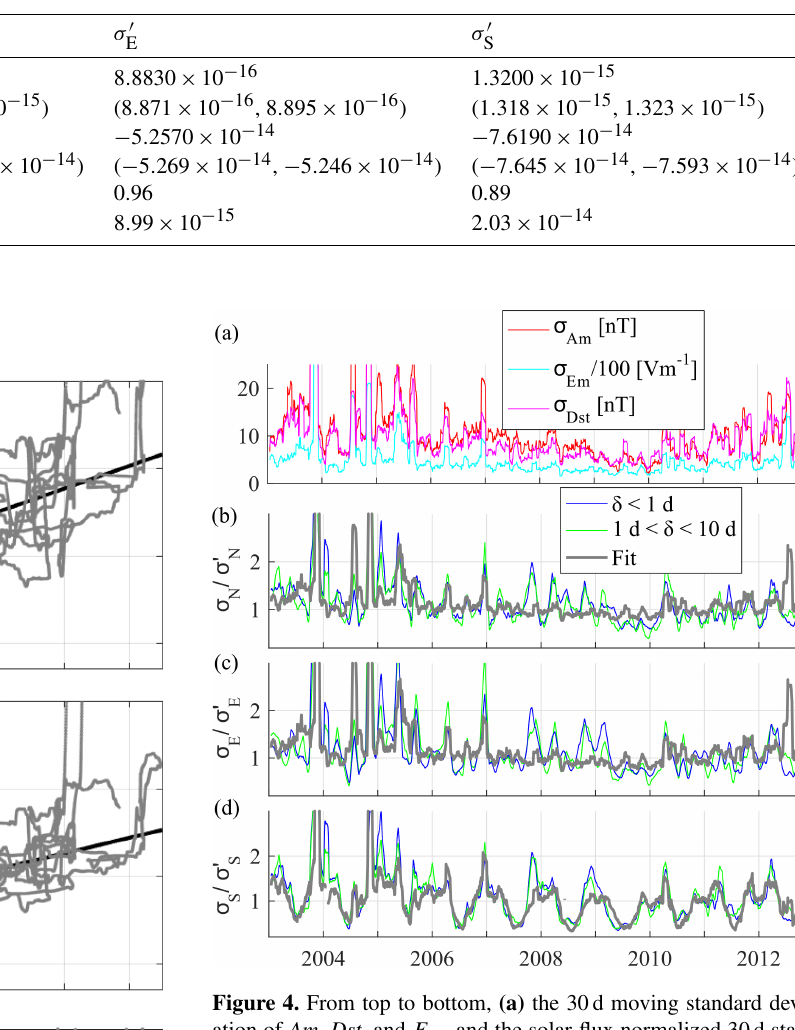
Table 1. Parameters and goodness of linear fit in Fig. 3. σ (cid:48) (F 10 . 7 81 ) = p 1 × F 10 . 7 81 + p 2.